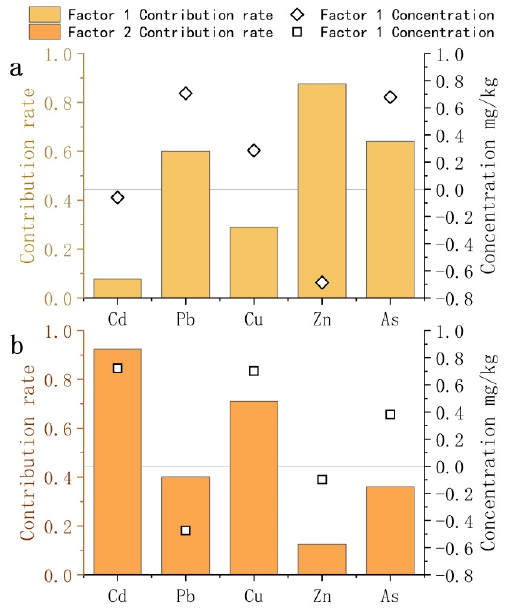
Figure 7. Source profiles and source concentrations of soil potentially toxic elements from PCA. (( a ) is the source profiles and source concentrations of soil potentially toxic elements for factor 1; ( b ) is the source profiles and source concentrations of soil potentially toxic elements for factor